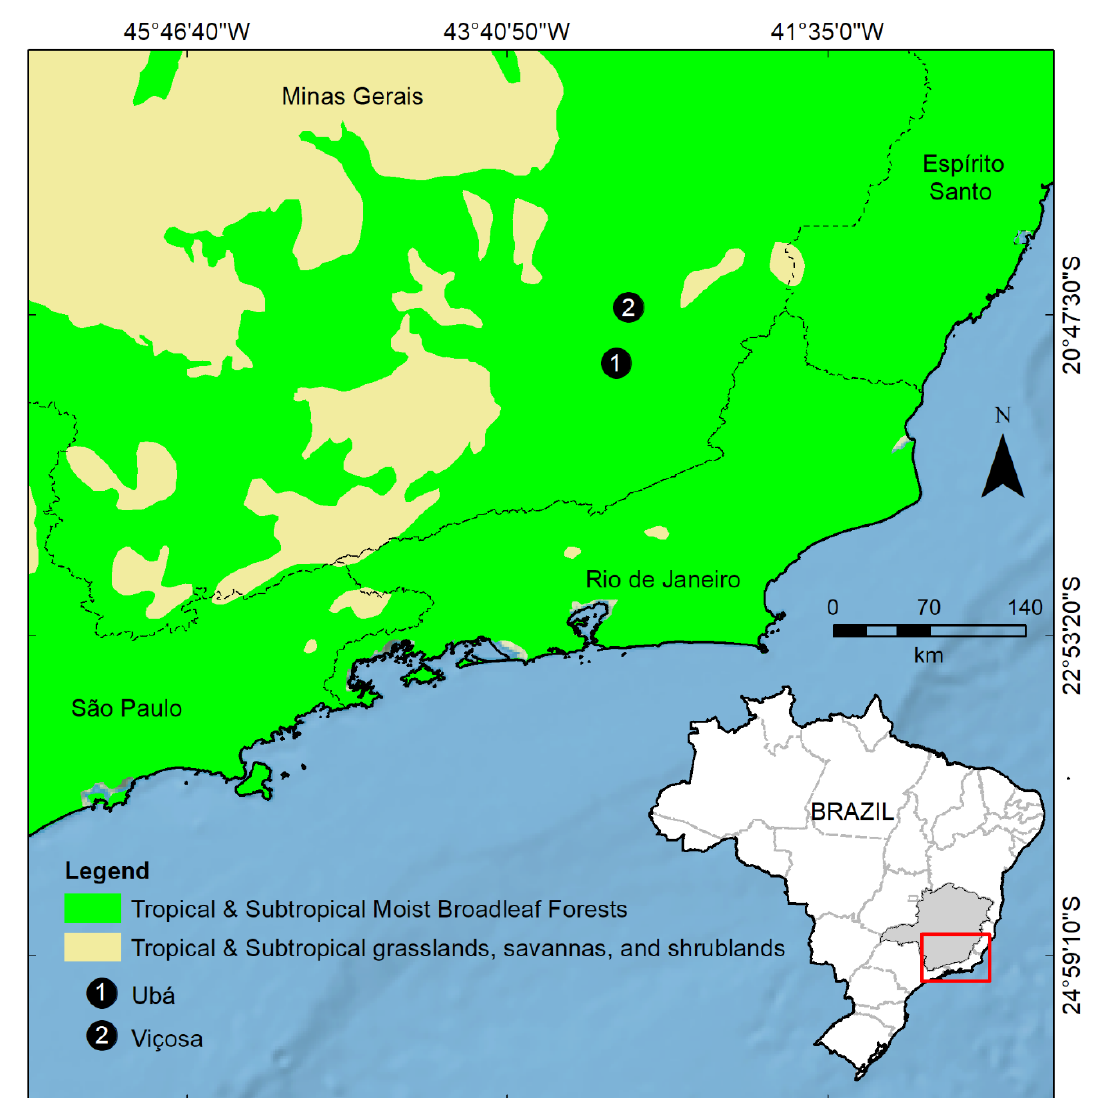
Fig 1. Map of the sampling localities of the ant taxa cytogenetically studied in this report from the Atlantic rainforest. Modified from Dinerstein et al.